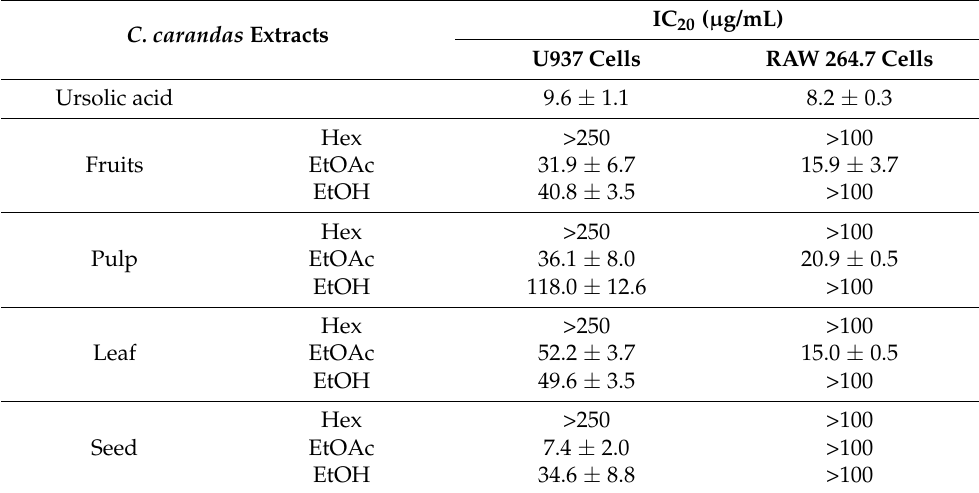
Table 2. IC 20 of each C. carandas extracts on U937 cells and RAW 264.7